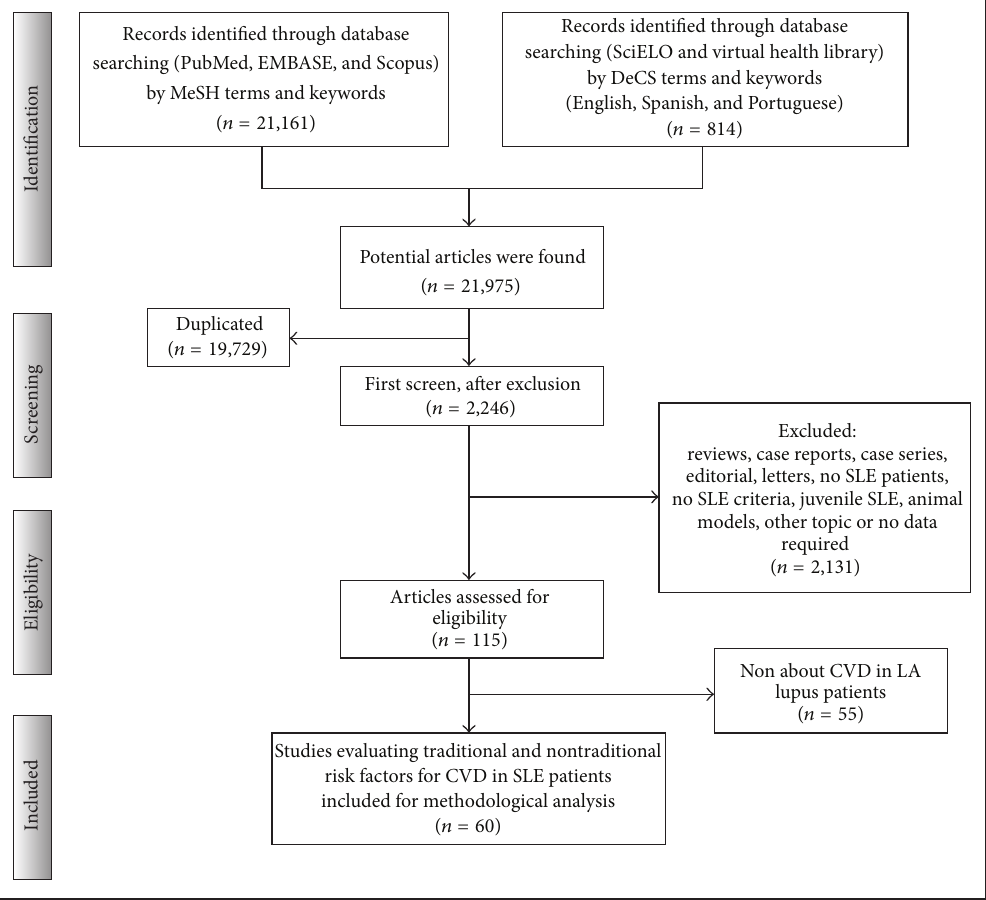
Figure 1: Flowchart of the systematic literature review. SLE: systemic lupus erythematosus, CVD: cardiovascular disease, LA: Latin America.